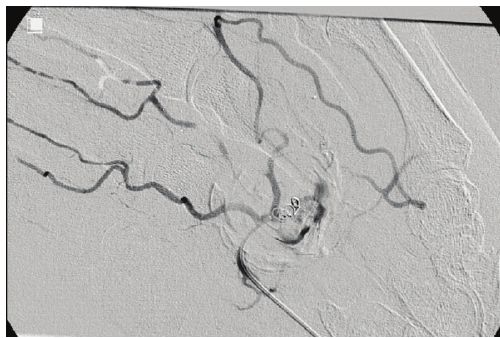
Figure 1: Pre-embolization picture of the swelling.